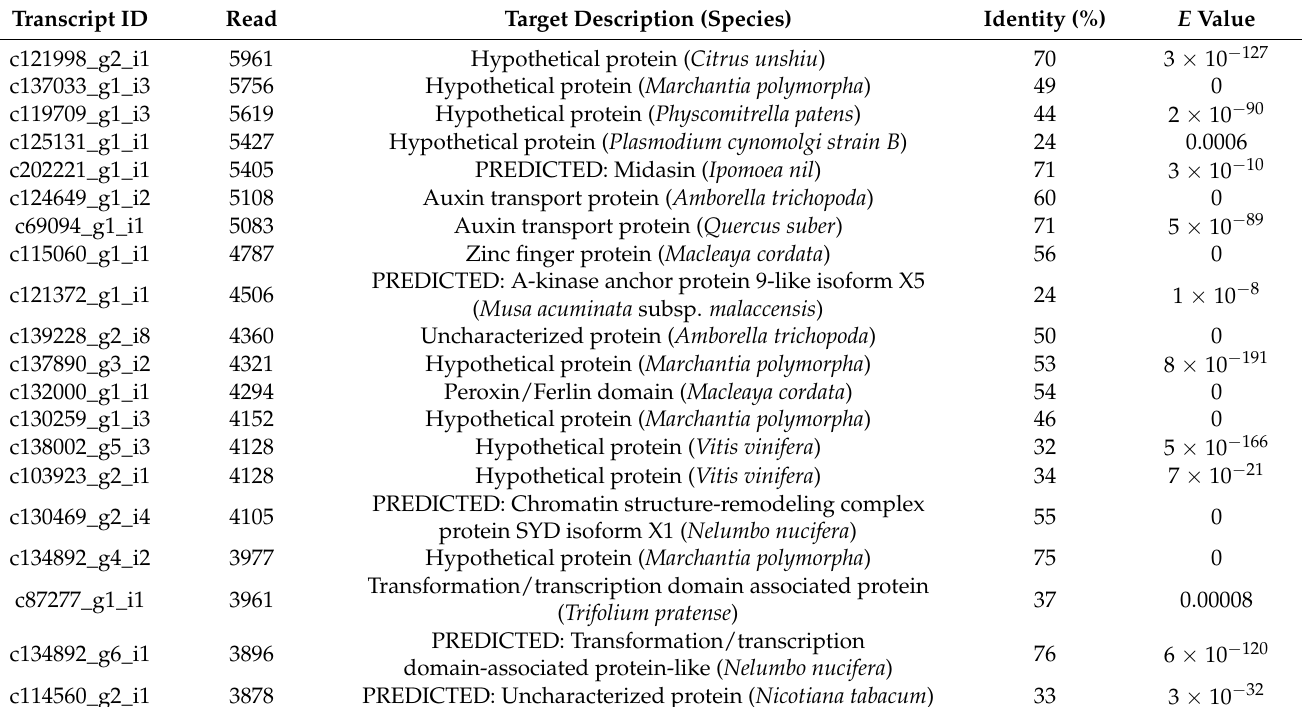
Figure 2. Distribution of the top BLASTX hits of conifers for unigenes in the NCBI Non- redundant database. Table 4. Most abundant transcripts in the T . koraiensis